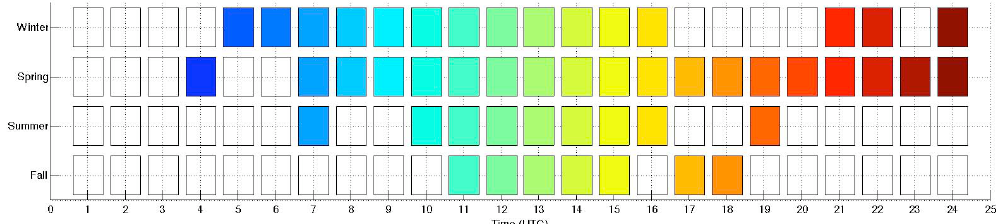
Fig. 4. Result of the Mann–Whitney U test applied on positive cluster ion concentration from event and non-event days. Squares are colored when the null hypothesis of samples with different medians cannot be rejected at the threshold of 5%. February 2007–February 2012, Puy de